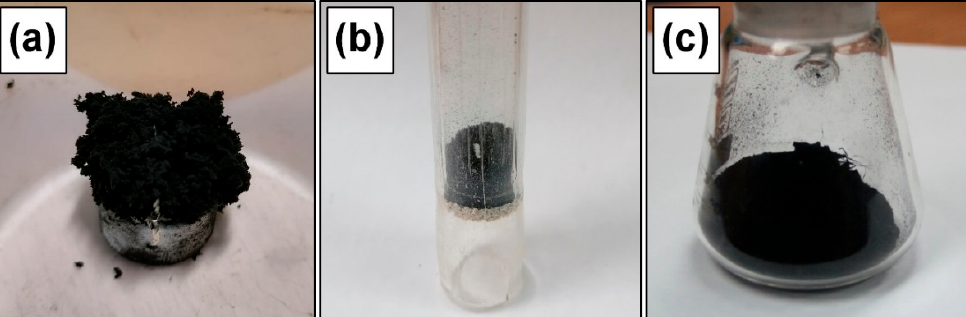
6 of 14 Figure 2. Kinetics of the carbon deposition over Ni-Pd catalyst at 600 °C for 2 h (reactor #1). In the second reactor scheme (Figure 1b), the quartz tube reactor with a quartz filter was used. The DCE-containing reaction mixture was also formed via the saturation route. The reaction gas flow goes upward through the filter and interacts with the uploaded sample. The efficiency of gas contact with the alloy particles was close to 100%, which is one of the advantages of this scheme. The second advantage is the more efficient preheat- ing of the reaction mixture before its entrance into the reaction zone. Moreover, a large amount of the catalyst can be uploaded into the reactor, which is also a positive feature. On the other hand, the reaction volume is limited by the reactor walls. As is known, the growth of filamentous carbon proceeds in all directions. Therefore, at low gas flow rates, the carbon product growing in both the axial and radial directions halts the reactor near the filter. The gas flow rates used in the presented experiments were optimized in order to achieve the fluidized bed regime. In this case, each catalytic particle with growing car- bon filaments is in motion. Such process parameters allow filling about 80% of the reactor volume. Herein, the process duration was also 2 h. Figure 3b demonstrates the reactor